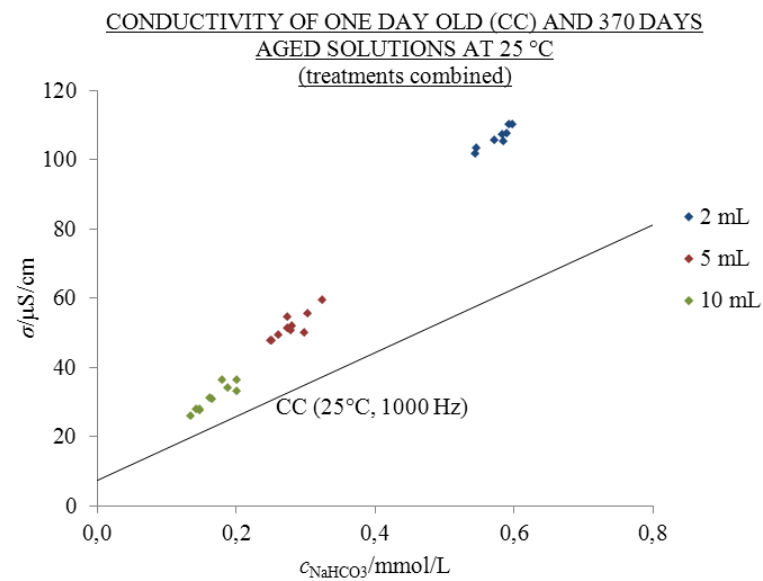
Figure 3. σ at 25 °C and 1000 Hz as a function of c of one-day-old (CC) and 370 NaHCO3 days in 2 mL (blue), 5 mL (red) and 10 mL (green) volumes of 20 mL flasks under condition PR aged solutions; points in the graph represent individual measurements; number of replicate solutions, N (/): 2 mL (8), 5 mL (10), 10 mL (10). Treatments are combined; conductivity above the CC line is